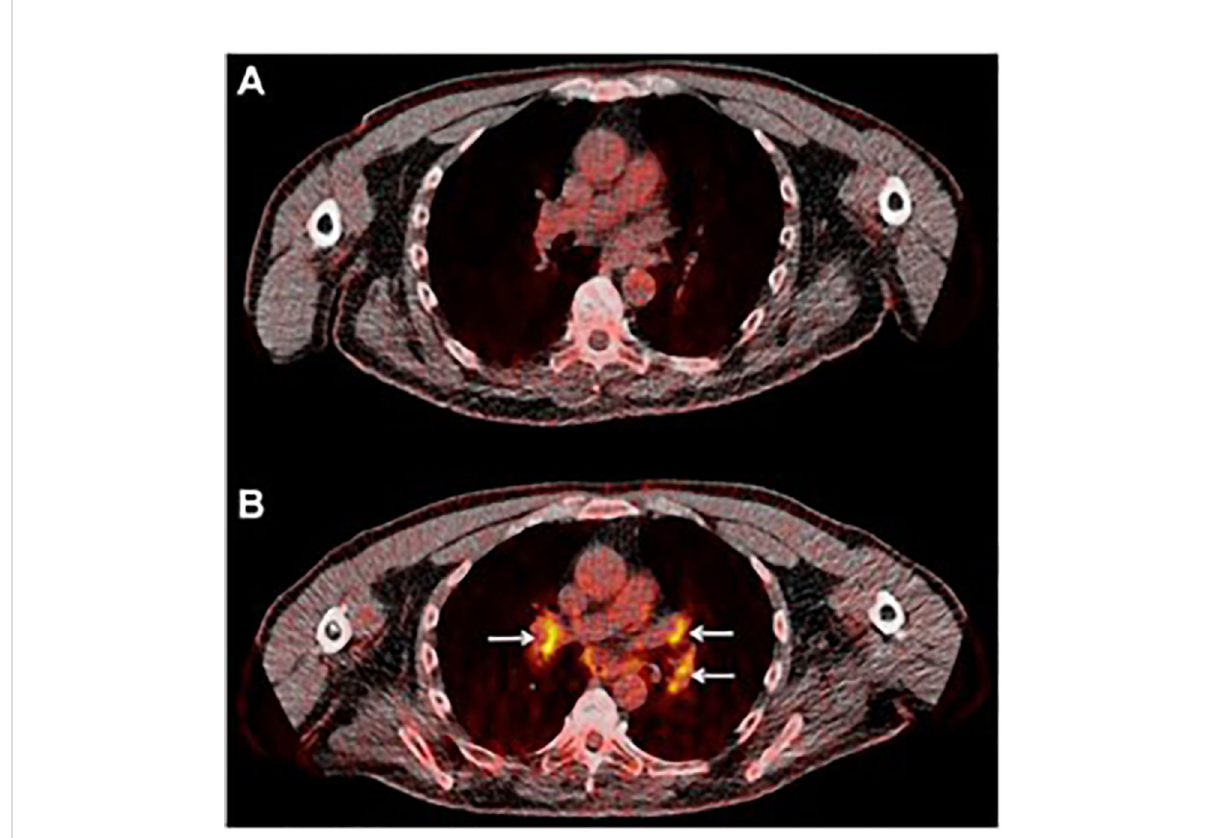
FIGURE 3 Sarcoid-like lymphadenopathy. (A) Transaxial FDG image of the thorax of a metastatic melanoma patient prior to starting immunotherapy (B) After two cycles of anti-CTLA-4 therapy FDG avidity in the mediastinal and hilar lymph nodes was evident. Adapted with permission from Springer Nature:Sachpekidis C, Larribere L, Kopp-Schneider A, Hassel JC, Dimitrakopoulou-Strauss A. Can benign lymphoid tissue changes in (18)F-FDG PET/CT predict response to immunotherapy in metastatic melanoma? Cancer Immunol Immunother.